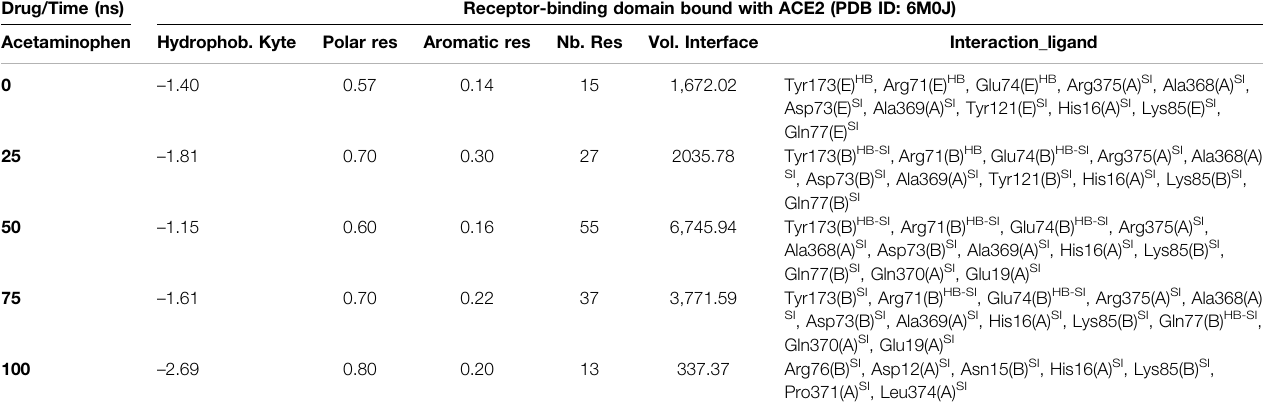
TABLE 7 | Biophysical characteristics associated with the amino acid composition of the Acetaminophen binding pocket at the RBD-ACE2 interface and as a function of simulation time. Drug/Time (ns) Receptor-binding domain bound with ACE2 (PDB ID: 6M0J) Acetaminophen Hydrophob. Kyte